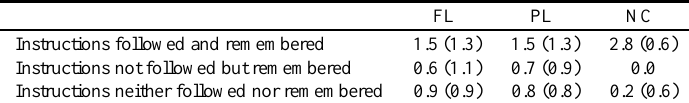
Fig. 2. Mean number of hits ( ± SEM) and false alarms ( ± SEM) in the face recognition task. Table 4 Results for the prospective memory test (means and